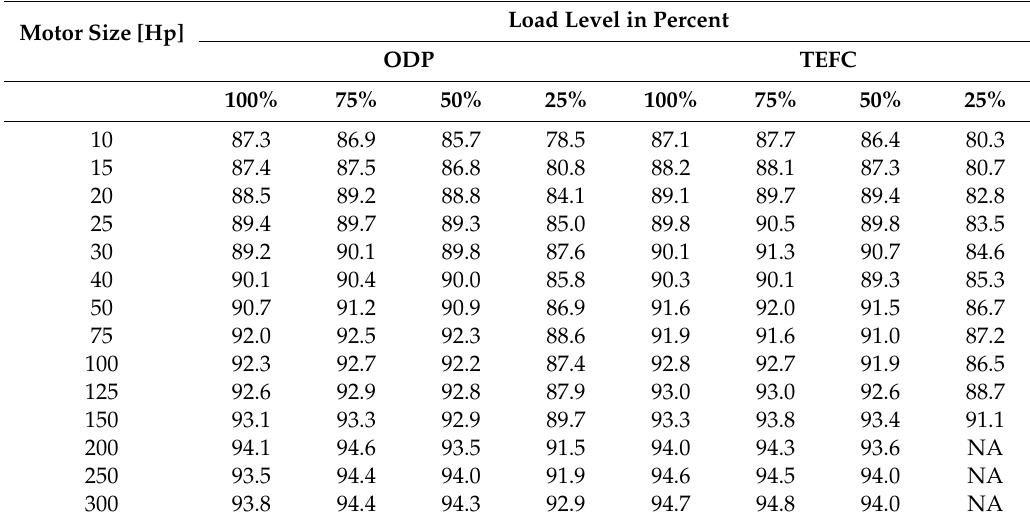
Table 6. Average E ffi ciencies for Standard E ffi ciency Motors n MOTOR at Various Load Points for 1200 RPM [30].